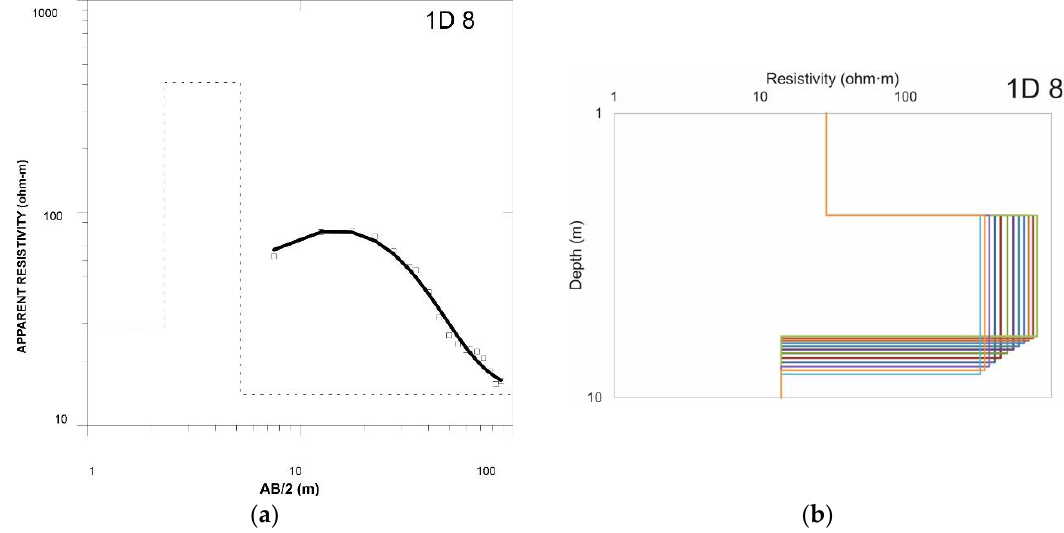
Figure 13. ( a ) Standard one-dimensional (1D) curve (in black) obtained at the Ca n’Albareda meander from experimental data (squares). ( b ) Equivalent geoelectrical models for the 1D 8.